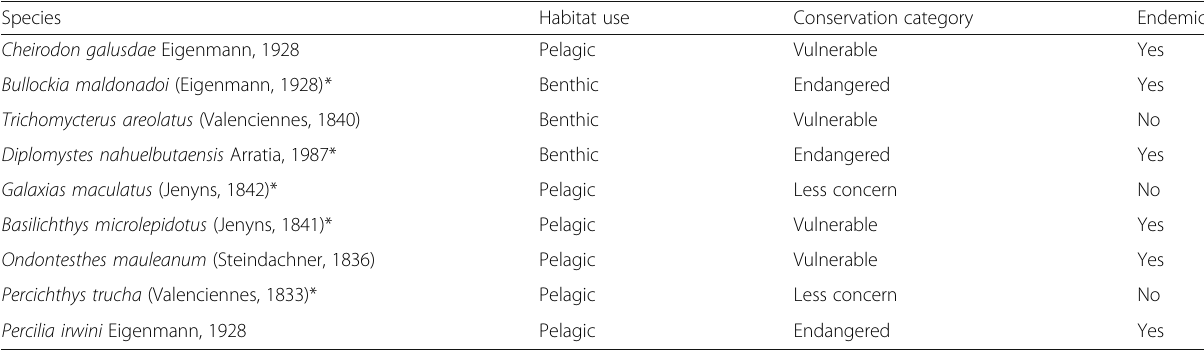
Table 2 Native fish species found in the Biobio river basin and some of their ecological features conservation status. Native fish species considered in planning optimisation case study are symbolised with asterisk (*)